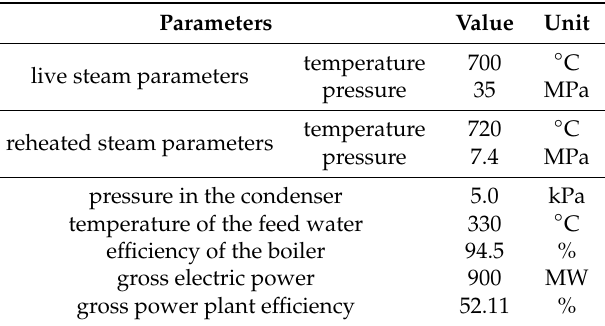
Table 2. The power plant operating parameters.